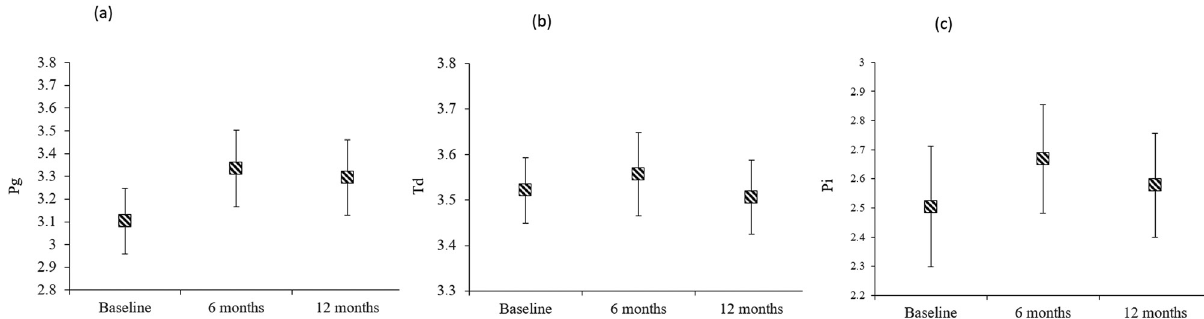
Figure 2- Comparisons of the counts of DNA copies of Pg, Td and Pi (copies/µl) at baseline and at 6 and 12 months postoperatively, irrespective of treatment groups, (a), Porphyromonas gingivalis , (b), Treponema denticola , (c), and Prevotella intermedia , respectively. p<0.05 considered statistically significant, repeated-measures analysis of variance test